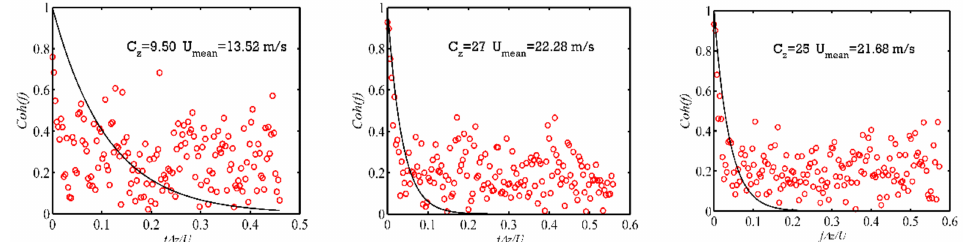
Figure 27. Coherence function at different wind speeds in the u